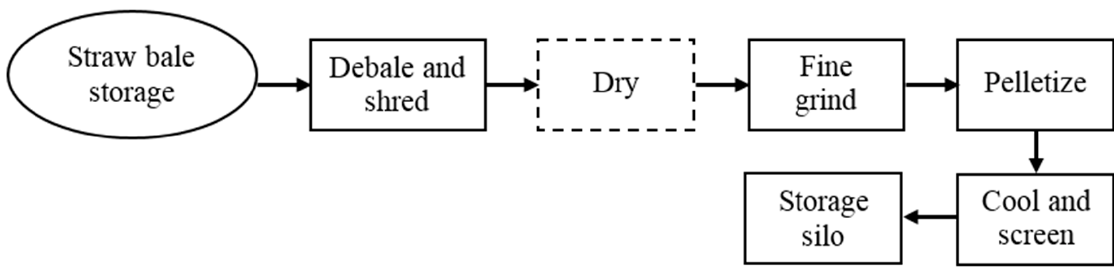
Figure 2. Sequence of operations in the upstream biomass logistics in the ag-pellet supply chain (adapted from [44,45]).